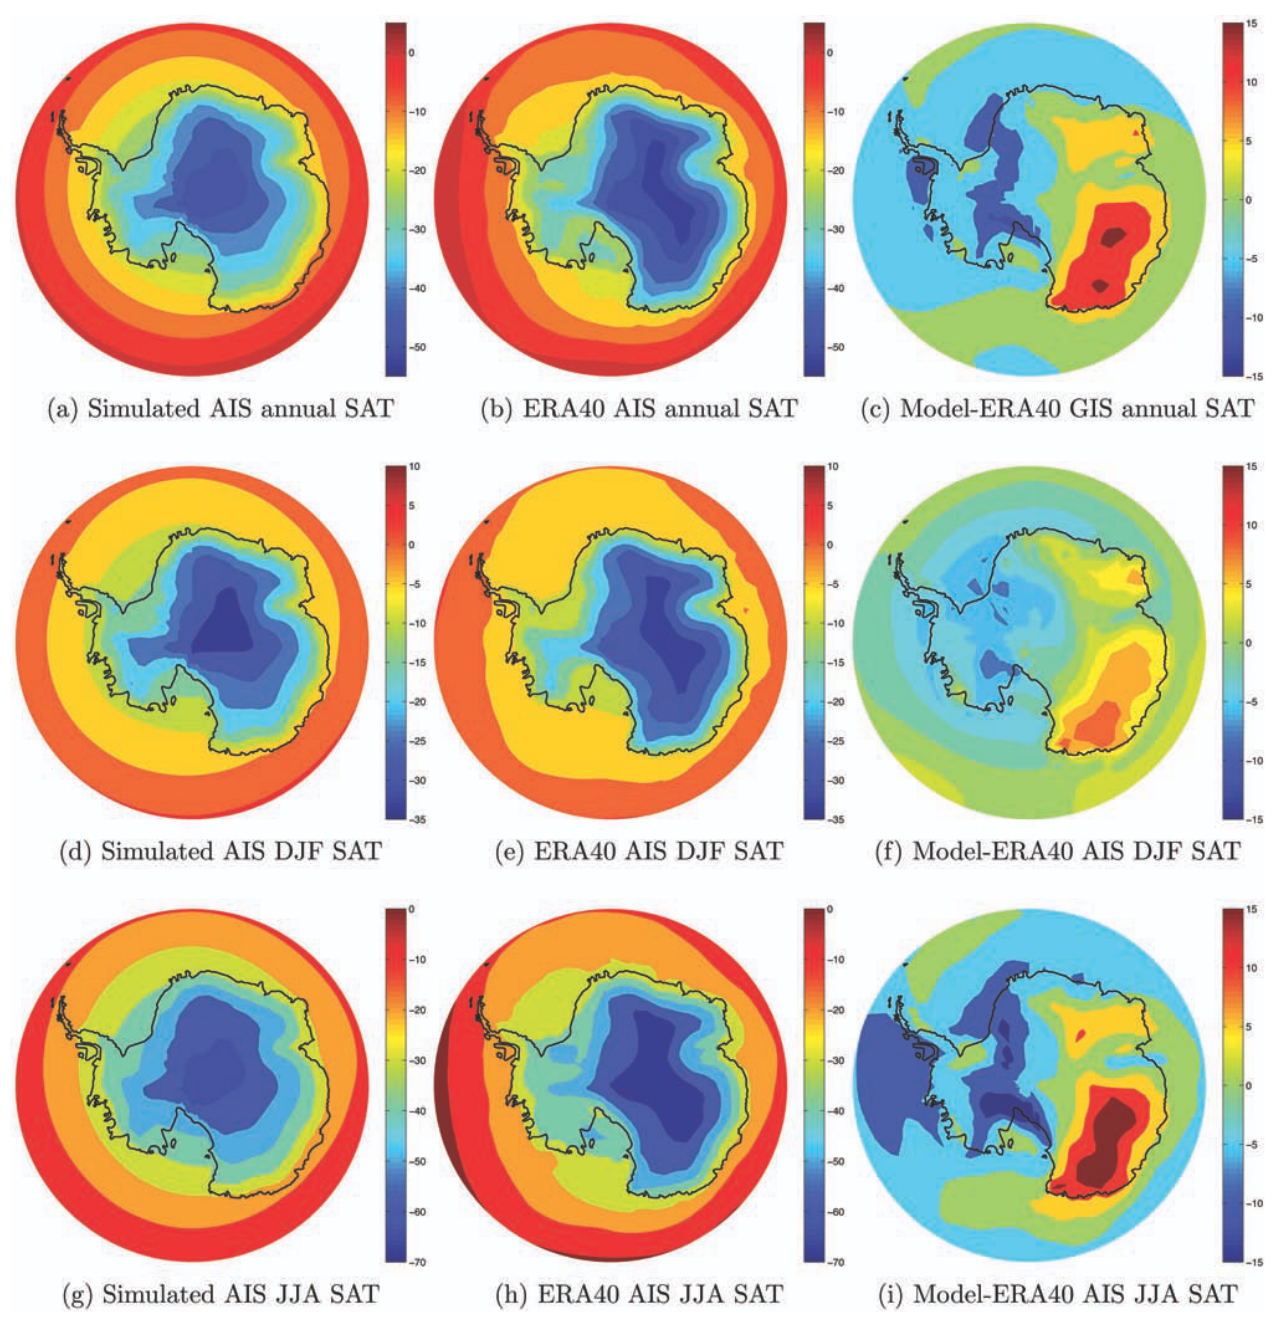
Fig. 7. Simulated/ERA40 1970–2001 annual, June-July-August (JJA, Austral winter) and December-January-February (DJF, Austral sum- mer) average SAT over the Antarctic Ice Sheet ( ◦ C). Note the different color scales for each seasonal